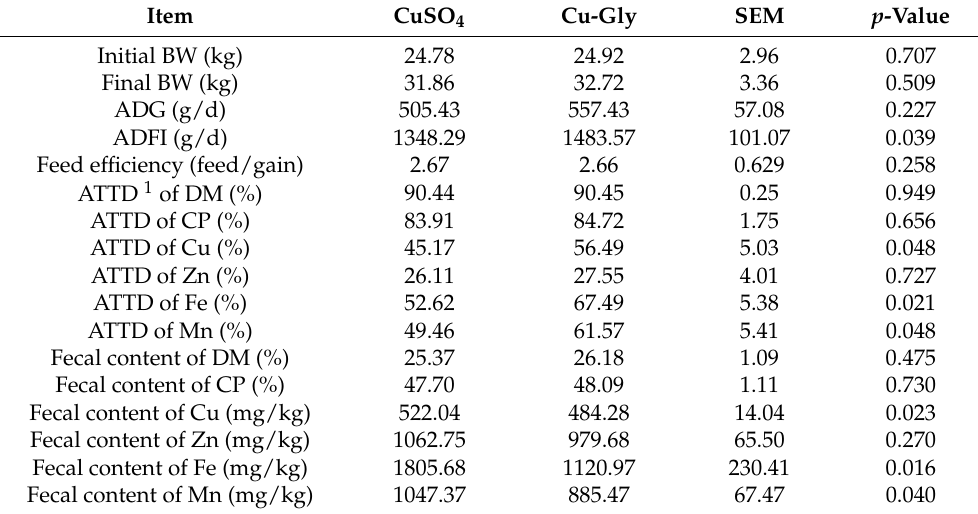
Table 2. Effects of Cu sources on growth performance, digestibility, and fecal microelement